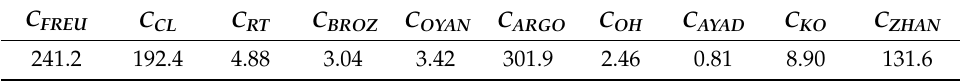
Table 4. Critical values of the damage function determined for C45 grade steel, formed at 1150 ◦